Question: Briefly state, in one sentence, what is plotted here.
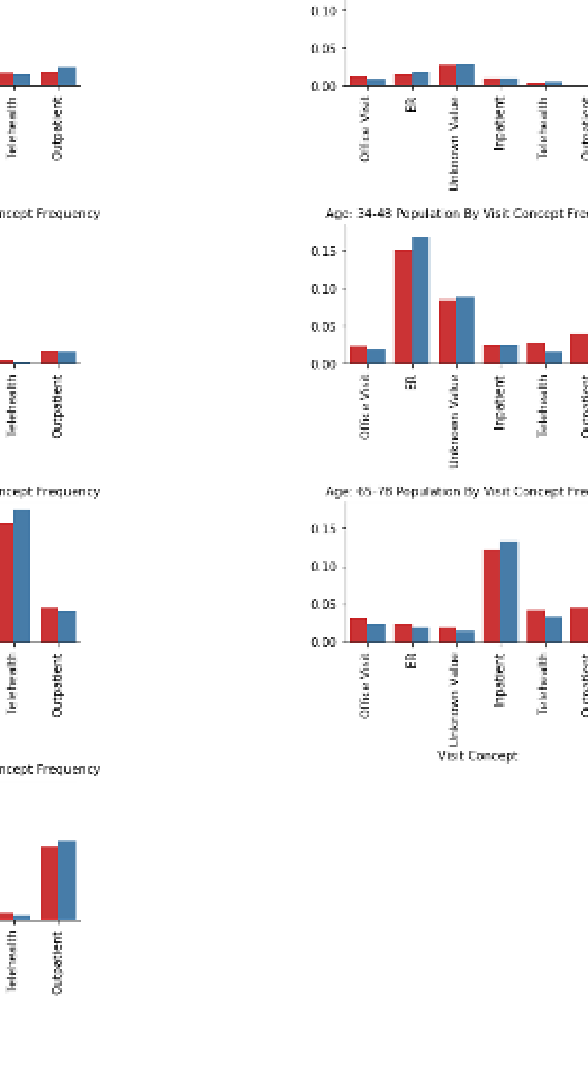
Answer: The visit prevalence stratified by age group